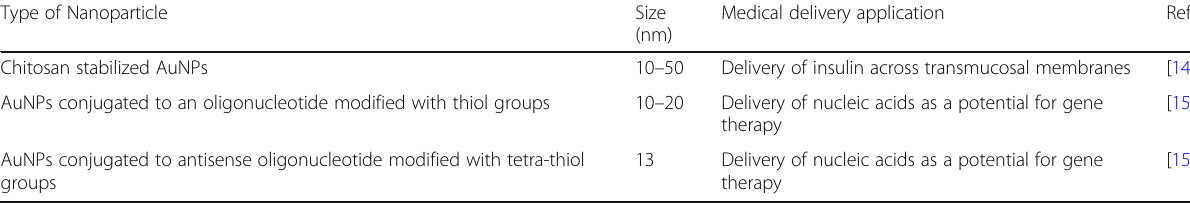
Table 4 A range of nanoparticle conjugates that have been examined for medical delivery of cargos Type of Nanoparticle Size